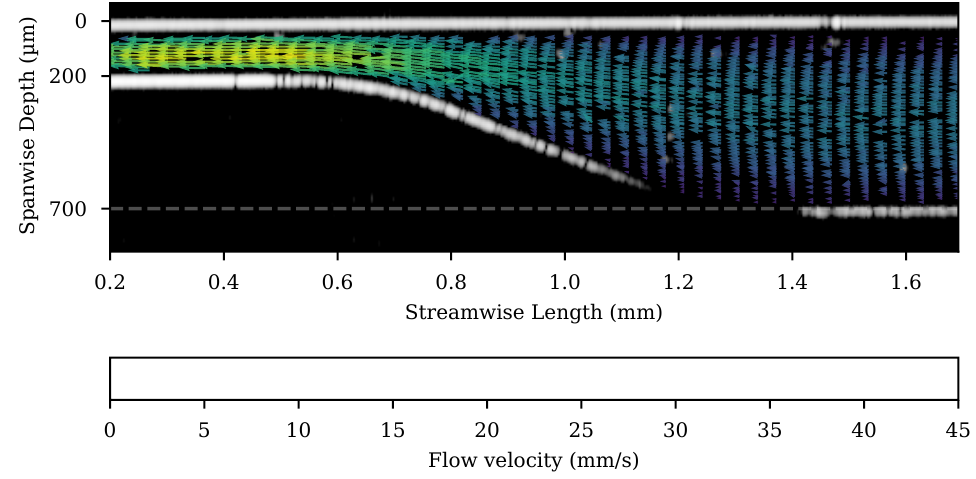
Figure 8. A flow velocity map is shown superimposed on a single OCT image frame from the sloped section of the channel. The whole channel is shown with every third streamwise bin plotted for clarity. The bins are 10µm square. The length of the velocity vector is additionally indicated by the colour bar. Missing arrows represent empty bins. The grey line at 700µm depth has been added to mark the position of the bottom of the channel on the